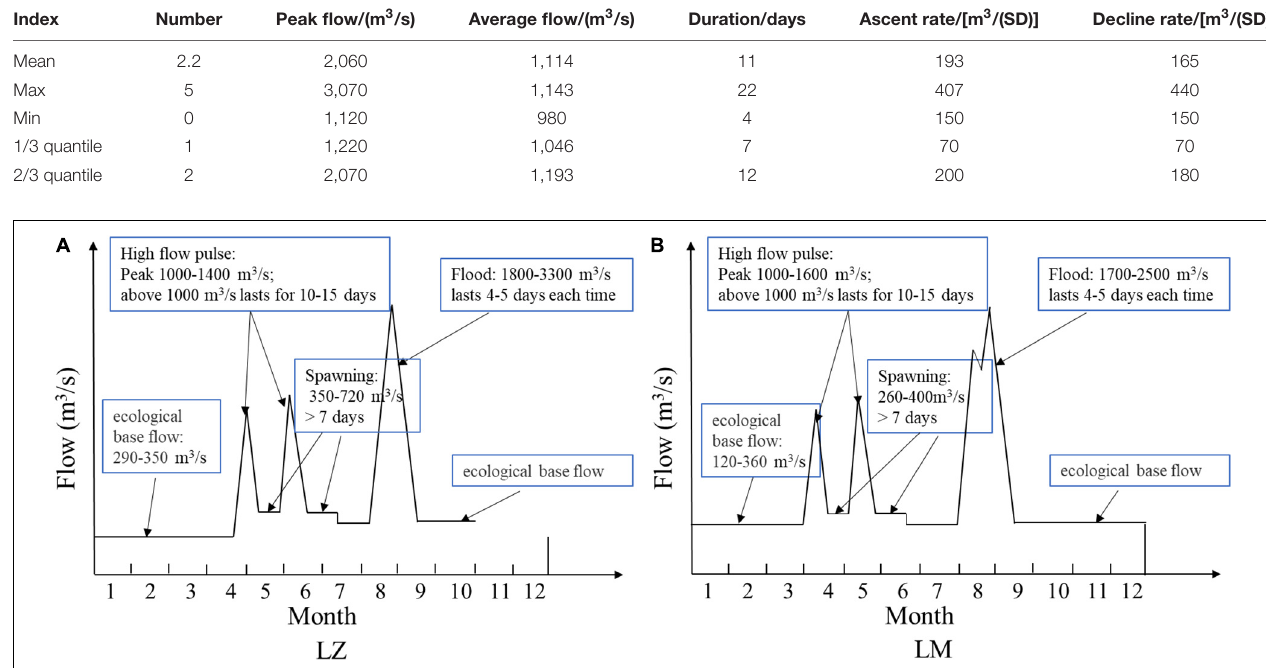
TABLE 5 | Characteristic values of the high flow pulse of Longmen during flood period before 1957.